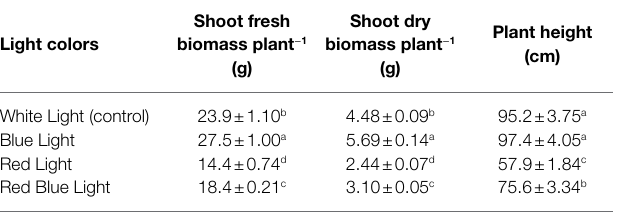
TABLE 1 | Changes in biomass and plant height of industrial hemp grown under varying colors of light.